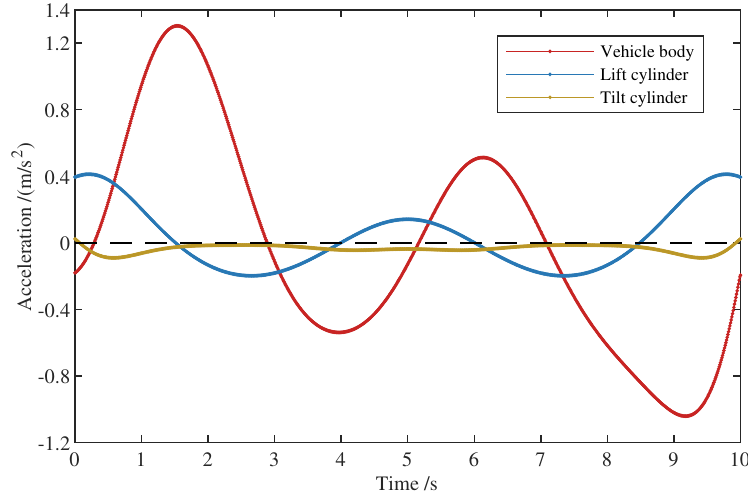
Figure 9. Acceleration curves of the vehicle body, lift cylinder, and tilt cylinder.